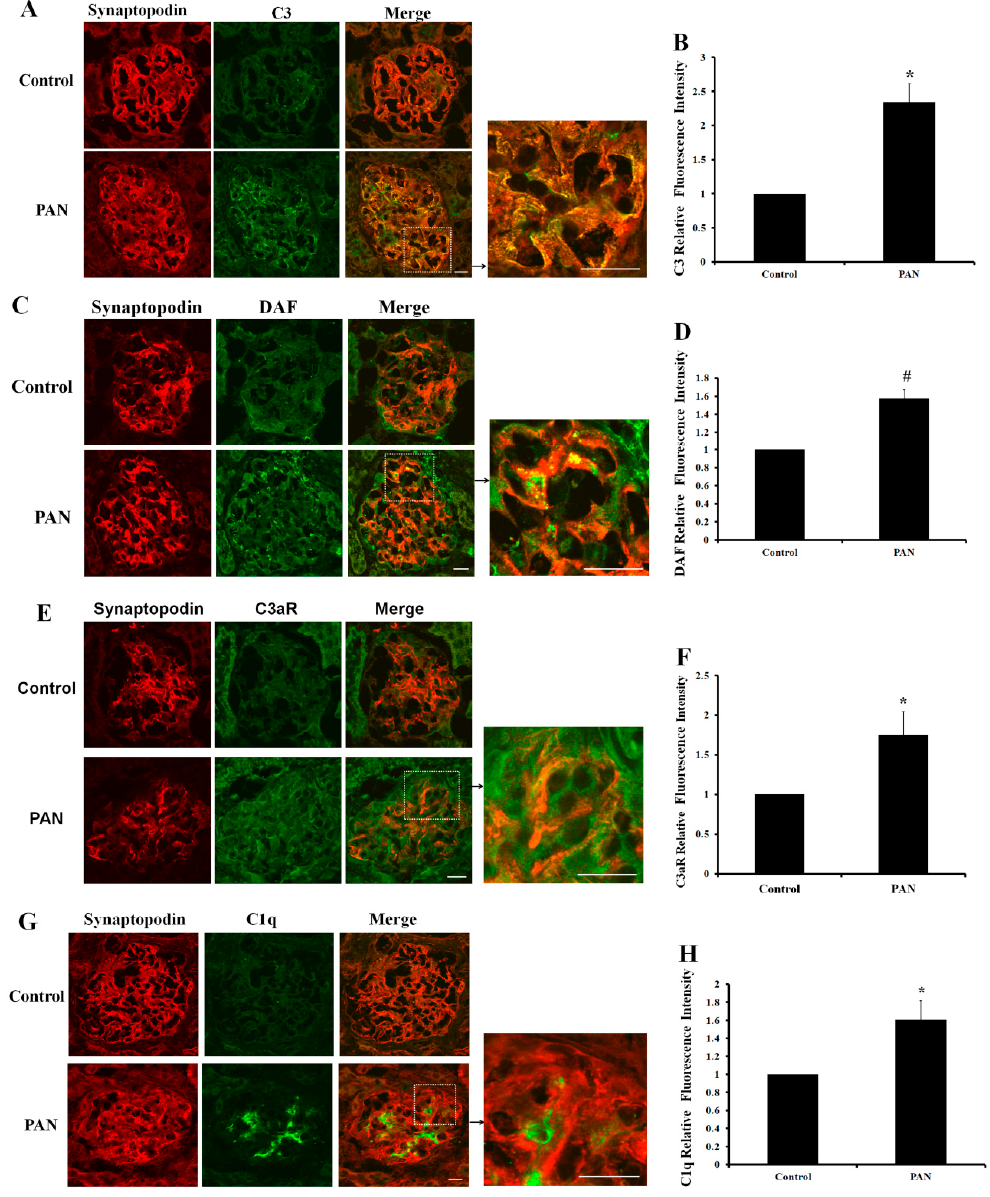
Figure 4. Cont. Figure 4.